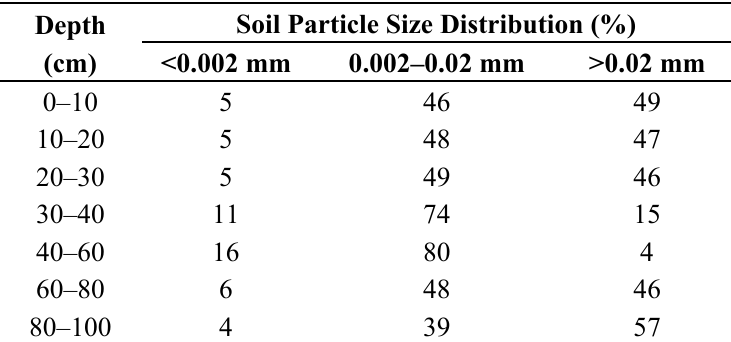
Table 3. Soil bulk density and particle size